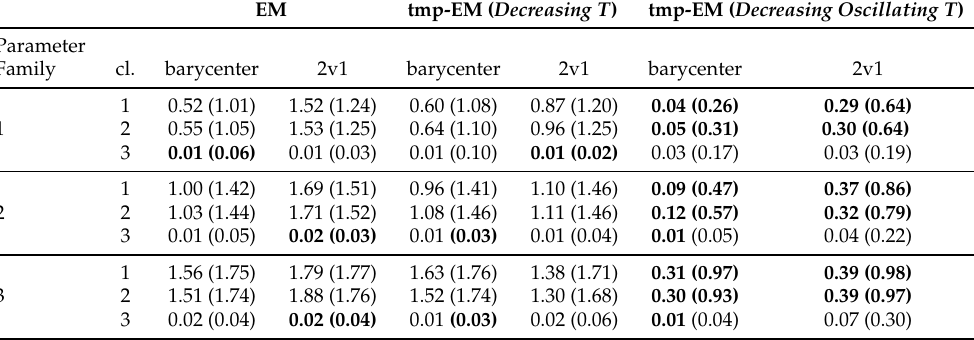
Table 1. Average and standard deviation of the relative error on µ k , (cid:107) ˆ µ k − µ k (cid:107) with decreasing temperature and tmp-EM with oscillating temperature over 1000 simulated dataset with two different initialisations. The three different parameter families, described in Figure 4, correspond to increasingly ambiguous positions of classes 1 and 2. For both initialisations type, the identification of these two clusters is drastically improved by the tempering. Best results highlighted in bold